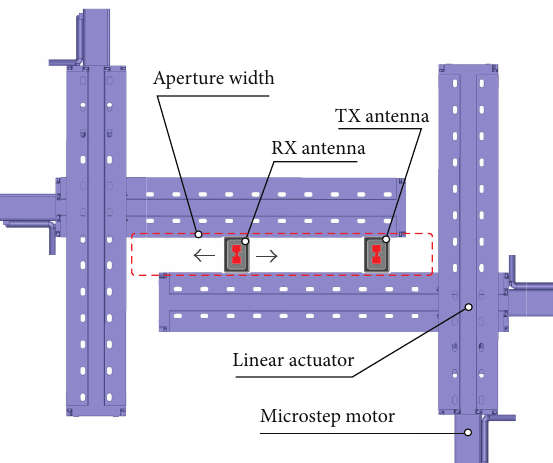
Figure 2: Schematic top view of the setup. The red dashed line iden- tifiesthetotalwidthofthesyntheticarray.Thegreyarrowssketchthe RX antenna movements.